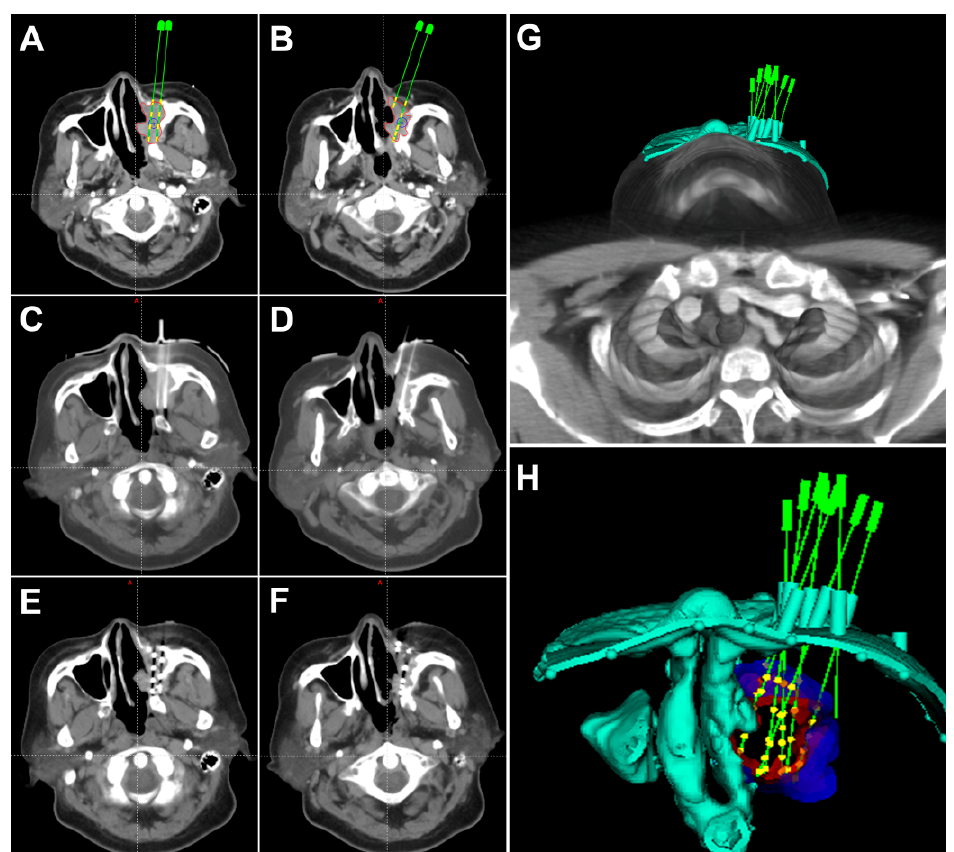
Figure 3. The CT images of pre-, intra- and post-operation. ( A , B ) show the preoperative treatment planning including the planned locations of needles, distribution of seeds and gross tumor volume (GTV). The green needles and yellow seeds are simulated needles and seeds in the brachytherapy treatment planning system (B-TPS), respectively. ( C , D ) show the actual locations of needles during operation. ( E , F ) show the actual postoperative distribution of seeds in target volume. ( G , H ) show the 3D-printing non-coplanar template (3D-PNCT) model with guide holes in the B-TPS.